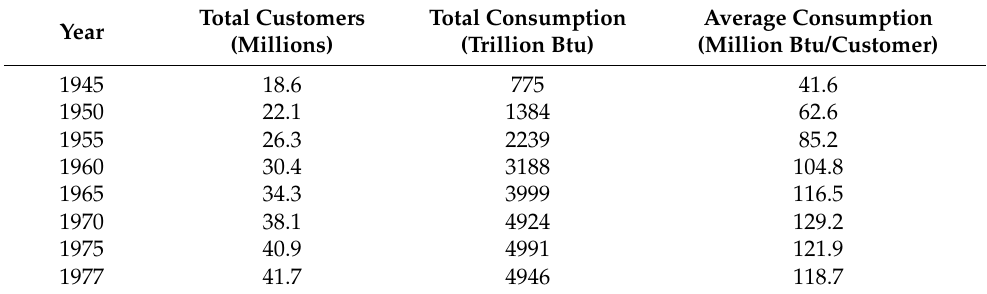
Table 5. U.S. domestic natural gas consumption from 1945 to 1977.